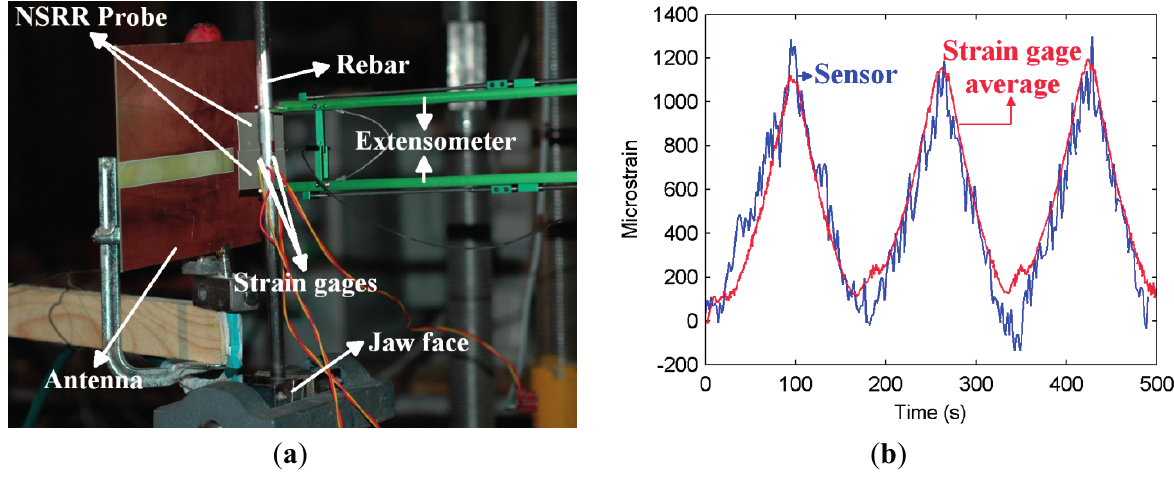
Figure 2. ( a ) High-force mechanical setup on which an 8-mm diameter rebar is pulled and released with a linearly varying force; ( b ) strain measured in time by the metamaterial-based sensor and the strain gauges (showing here the average strain gauge